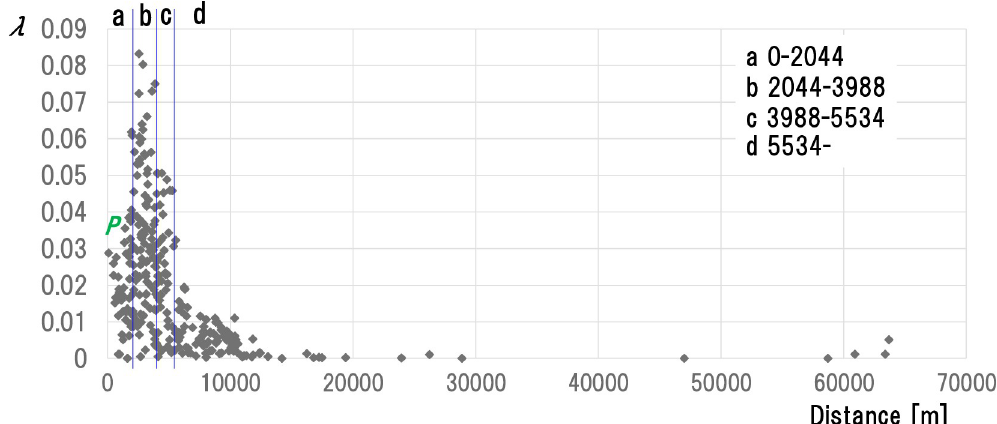
Fig 7. Stratified results based on the distance from the center of gravity. The horizontal axis represents the distance from the center of gravity (CG0 or CG1 or CD2 or ... or CG65). The vertical axis represents the scattering index λ . It associates each point with the 292 farms infected during the infection period. For example, point P (1586, 0.0365) associates with one farm ( F 20 1 ) confirmed infected on the 20th day (Day 20) after the outbreak. 1586 represents the distance from the center of gravity (CG20) of the day (Day 20) for the farm ( F 201 ), and 0.0365 represents the scattering index for the farm ( F 201 ) on Day 20. We performed stratification based on the distance from the center of gravity for all points in the above graph. The cluster area obtained from the stratification result is a, b, c, d. Here, region a is 0 or more and less than 2044m from the center of gravity (CG0 or CG1 or CD2 or ... or CG65). b is 2044m or more and less than 3988m, c is 3988m or more and less than 5534m, and d is 5534mor